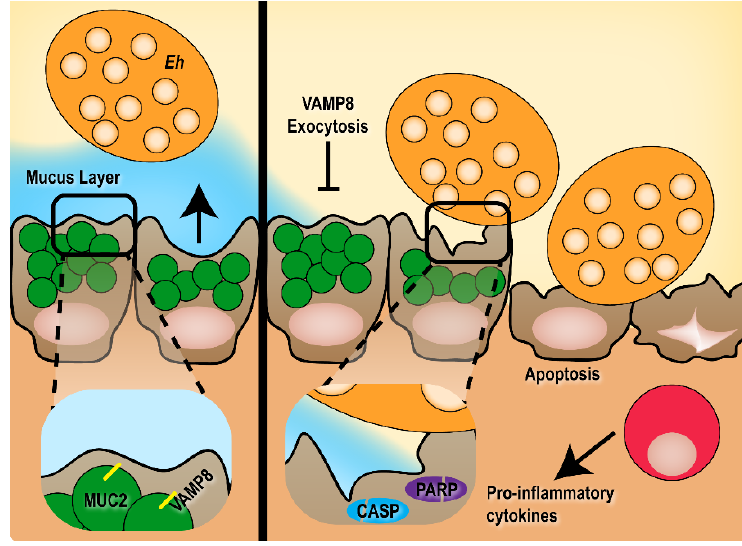
FIGURE 1: The pathogenesis of E. histolytica in the absence of VAMP8-mucin exocytosis. Under normal conditions (left), E. histolytica ( Eh ) colonizes the mucus layer and induce VAMP8-dependent mucin exocytosis when in close proximity to goblet